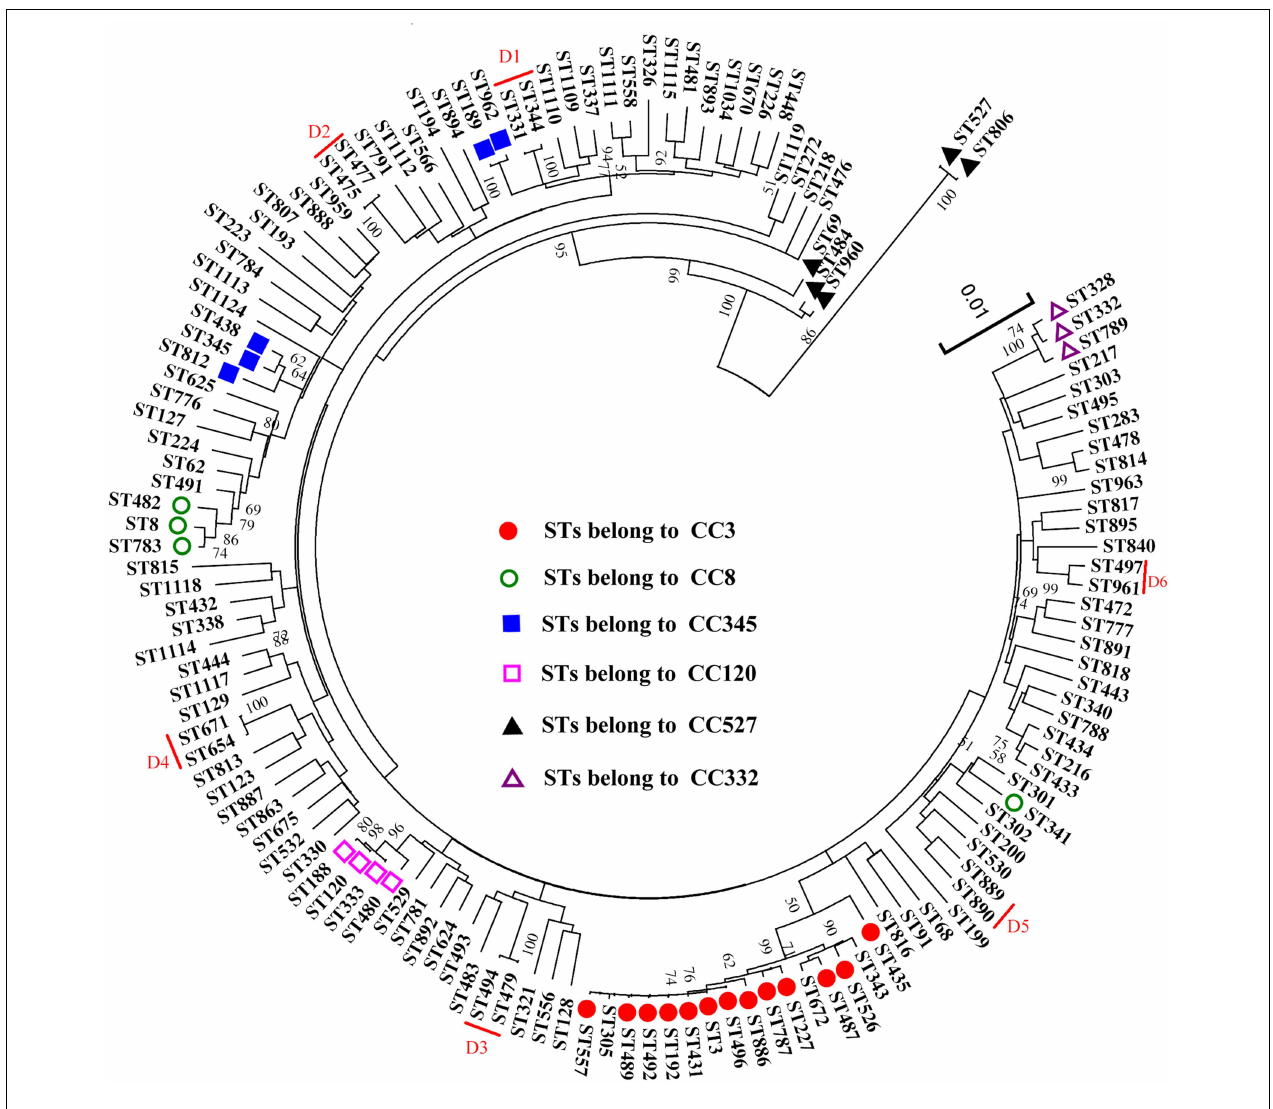
represent the six CCs observed by goeBURST, the six doublets marked by red lines. The scale represents the evolutionary distance. Bootstrap values over 50% are shown on the